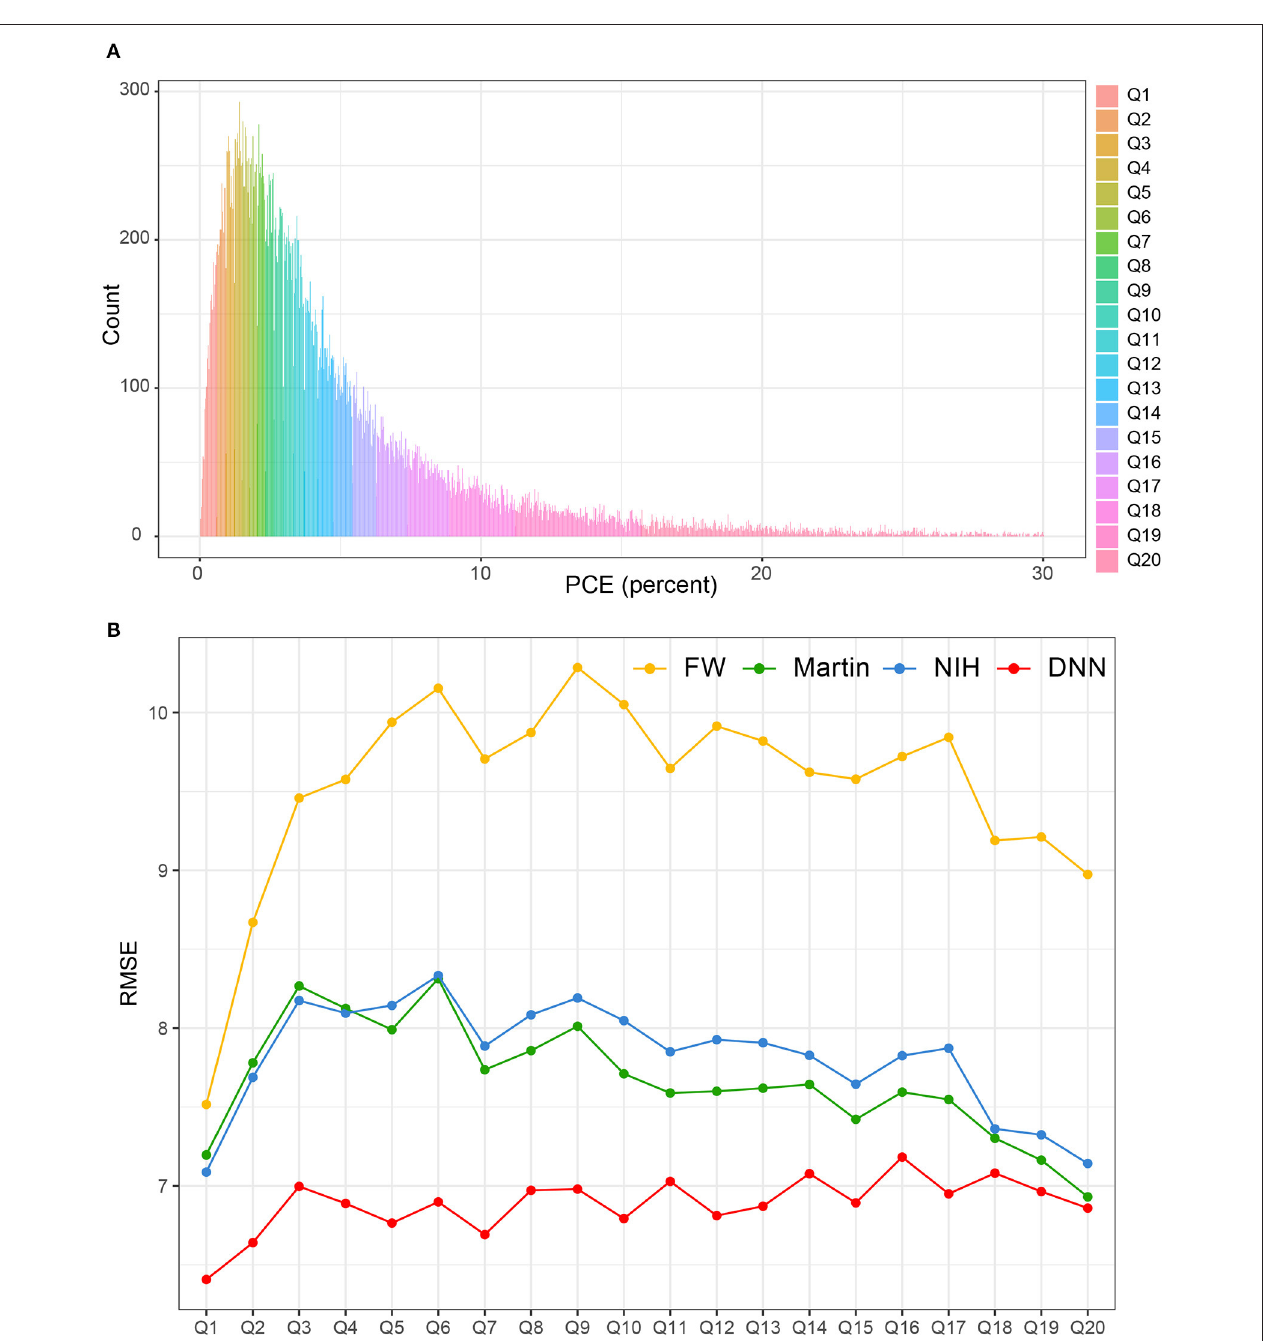
FIGURE 7 | Comparison of RMSE in the four LDL estimation models across the PCE categories. PCE, pooled cohort equations. (A) PCE scores were classified based on the 20th decile. (B) The RMSEs of each LDL-C estimation methods were separately calculated according to each of the 20 PCE categories. results were consistently concordant with those of previous studies. LDL- C DNN had the lowest bias and RMSE of the four methods tested. Particularly, the higher ratio value of LDL- C DNN from P20 to P10 indicates that LDL- C DNN better predicts serum LDL-C within a smaller margin of